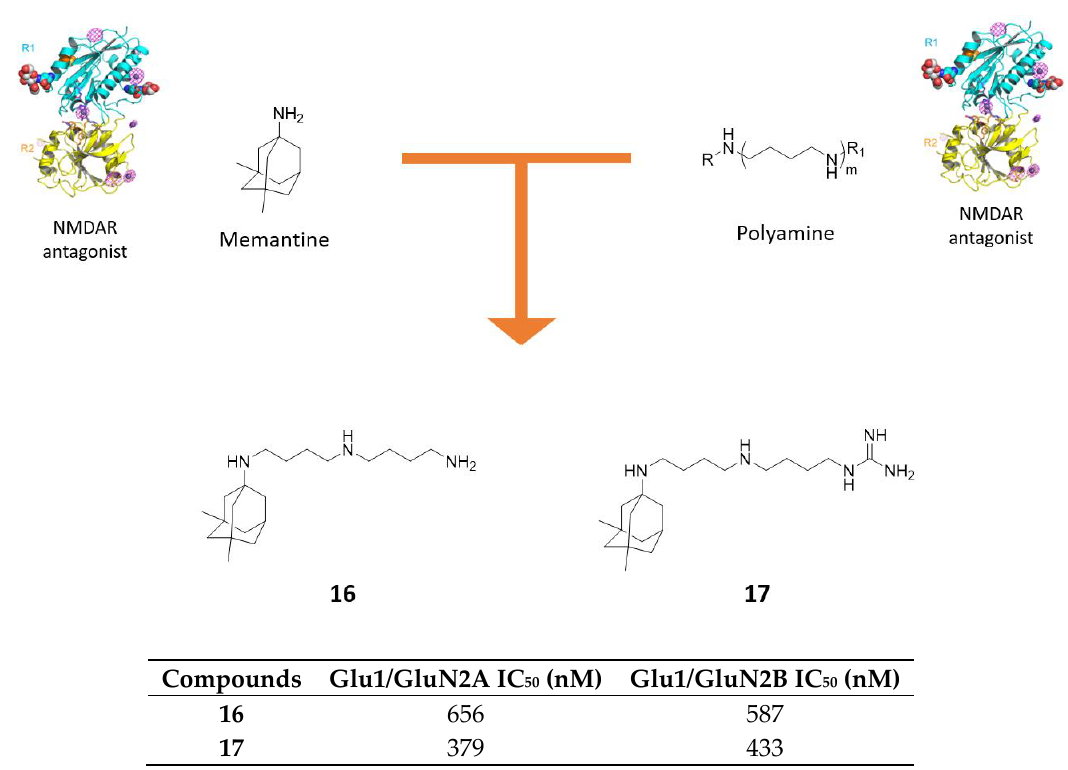
Figure 10. Drug design and biological activities of polyamine-memantine hybrids 16 and 17 .